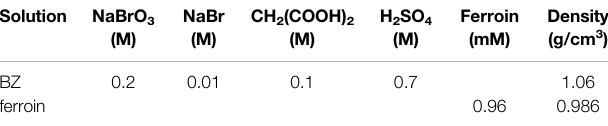
TABLE 1 | Concentrations of constituents of the BZ and ferroin